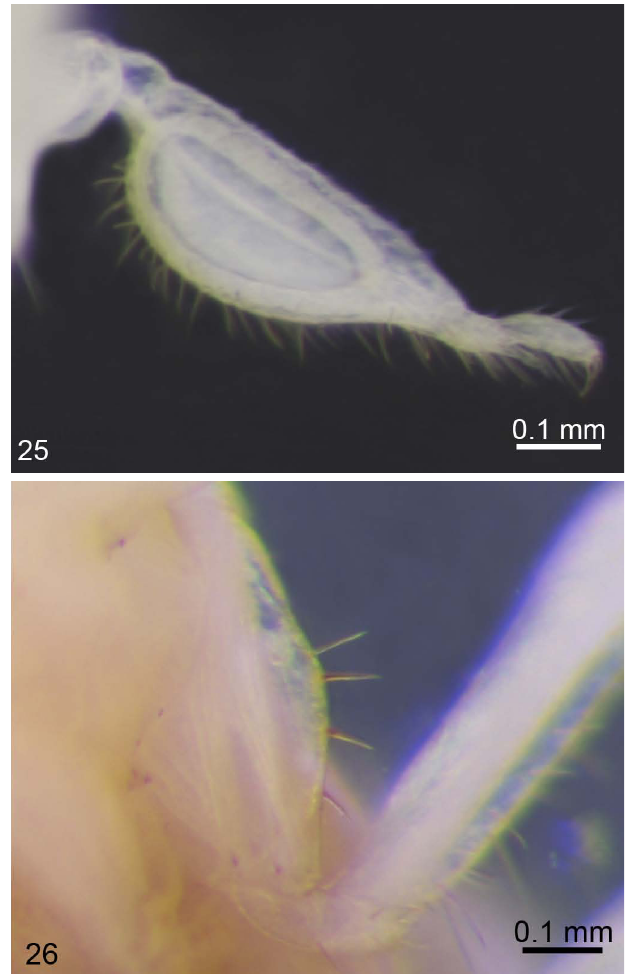
Figs 25–26. Worker legs of Apicotermitinae: 25- Tetimatermes oliveirae , spoon-like tibia; 26- Rubeotermes jheringi , thick bristles on forecoxae.